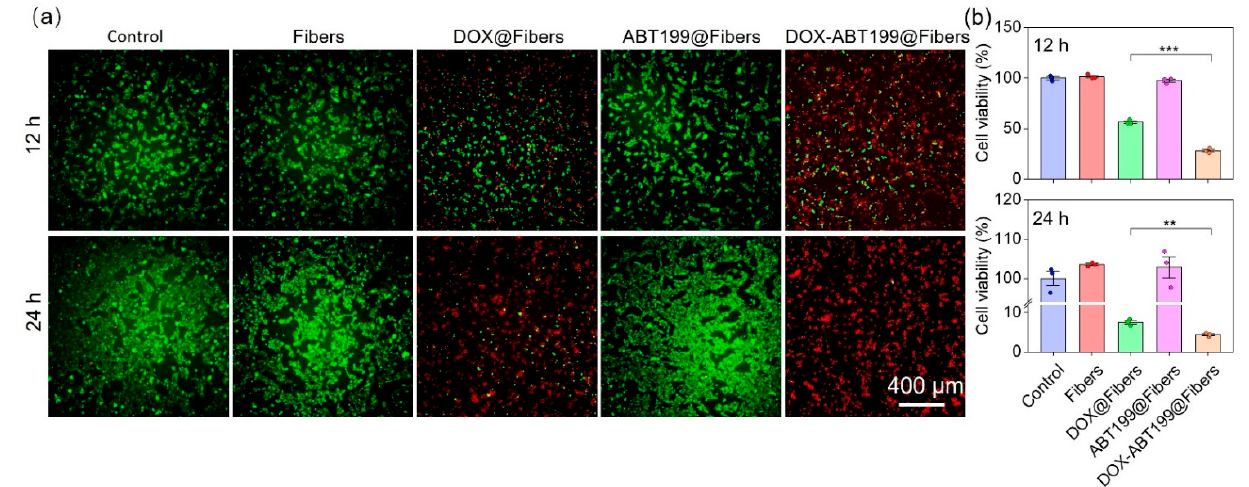
Figure 5. Evaluation of anti-tumor effect of electrospun fibers loaded with different components in vitro. ( a ) Live/Dead staining of RM-1 cells was performed after treatment with different materials for 12 and 24 h, and ( b ) the cell viability was evaluated via CCK-8 kit assay (*** stands for p < 0.001 and ** stands for p < 0.01).